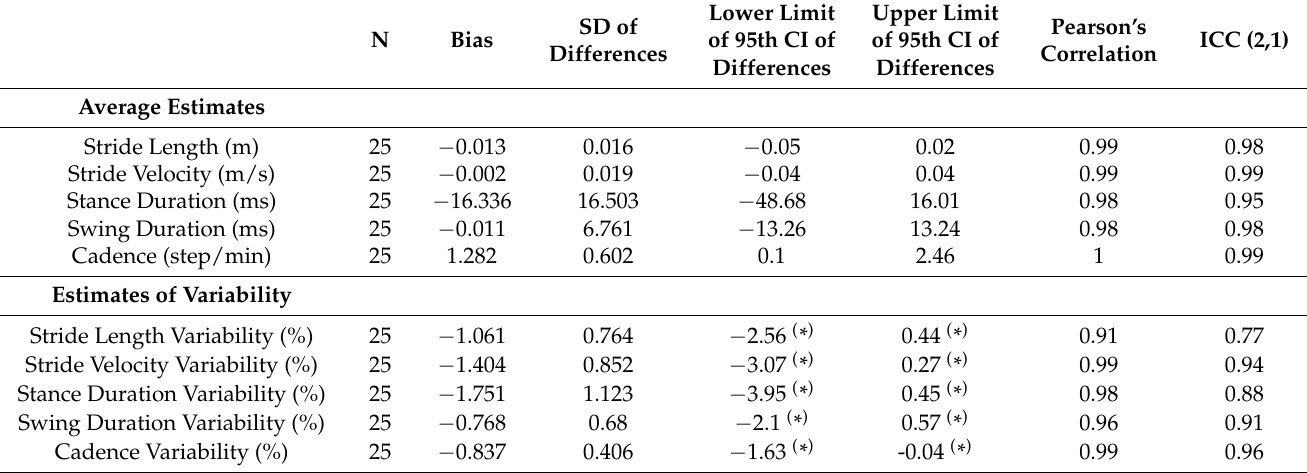
Table 3. Values of average estimates and estimates of variability for the unipedal gait parameters with the following statistics: sample size (N), the bias: mean of (insoles-GAITRite ® ), SD of differences: SD of (insoles-GAITRite ® ), lower and upper limits of 95th CI of differences, Pearson’s correlation and intra-class correlation coefficients between GAITRite ® and the insoles. ( * ) Note that the CI for the CV estimates are approximate only, based on t-intervals, as the underlying distribution is not